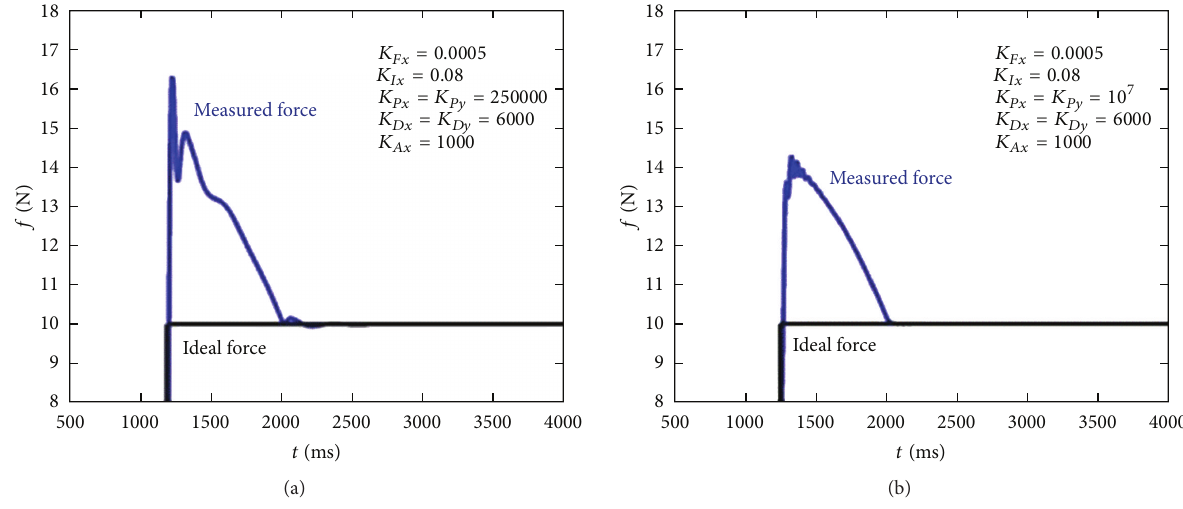
Figure 22: End-Effector force value (N) varying the 𝐾 𝑃 gain in the PI system: (a) 𝐾 𝑃 = 250000 ; (b) 𝐾 𝑃 = 10 7 .